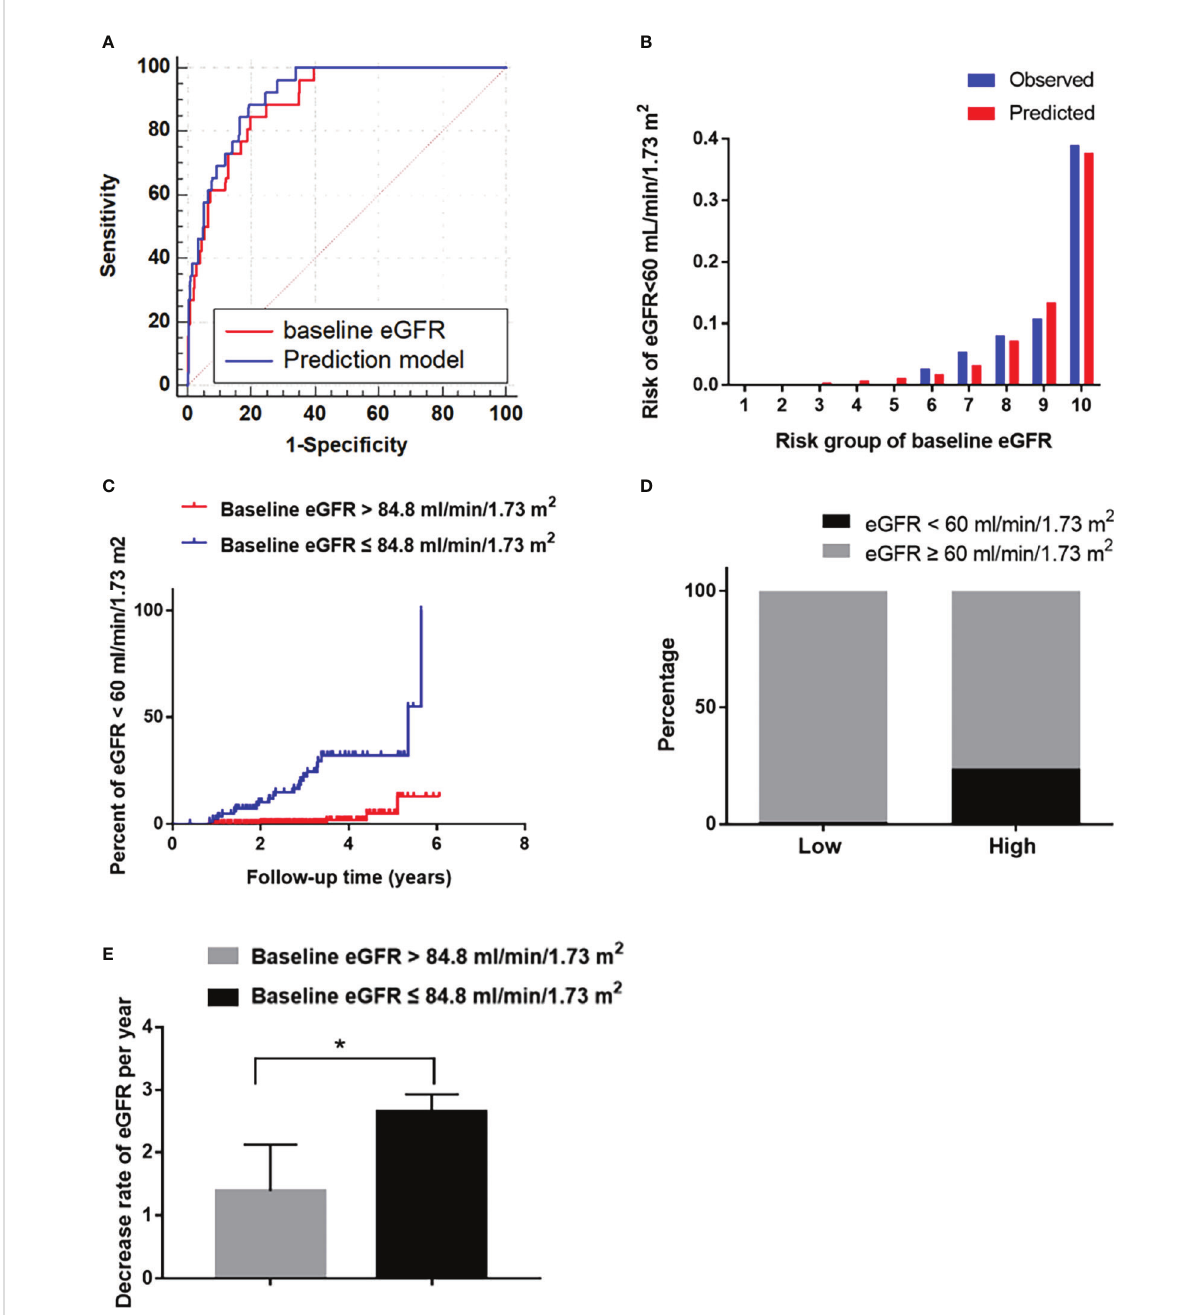
FIGURE 2 The performance of the baseline eGFR in predicting reduced eGFR in the development cohort. (A) Receiver operating characteristic curve for the baseline eGFR and the prediction models. The area under the curve (AUC) and its 95% CI were 0.90 (0.85 – 0.96) for the baseline eGFR and 0.91 (0.87- 0.96) for the prediction model; The discriminative power of baseline eGFR vs prediction model ( P =0.381). (B) Hosmer-Lemeshow (H-L) test for the calibration of the baseline eGFR ( P =0.87). (C) Kaplan-Meier curve of reduced eGFR end point for the low-risk (eGFR >84.8 mL/min/1.73 m 2 ) and high- risk (60 ≤ eGFR ≤ 84.8 mL/min/1.73 m 2 ) groups strati fi ed according to the cut-off value. The HR (95% CI) was 17.47 (6.00-50.81) ( P <0.001) in the high- risk group. (D) Prevalence of reduced eGFR in the low-risk (eGFR >84.8 mL/min/1.73 m 2 ) and high-risk (60 ≤ eGFR ≤ 84.8 mL/min/1.73 m 2 ) groups. (E) : The decrease rate of eGFR per year in the low-risk (eGFR >84.8 mL/min/1.73 m 2 ) and high-risk (60 ≤ eGFR ≤ 84.8 mL/min/1.73 m2) groups. * P <